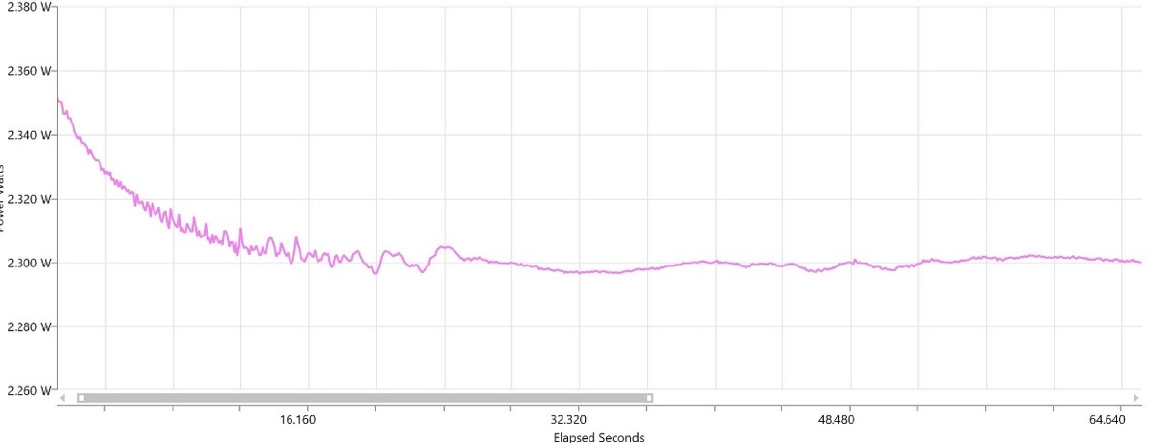
Figure 1. Representative power output of the SIROLaser Blue (445 nm) in continuous-wave mode over 60 s.